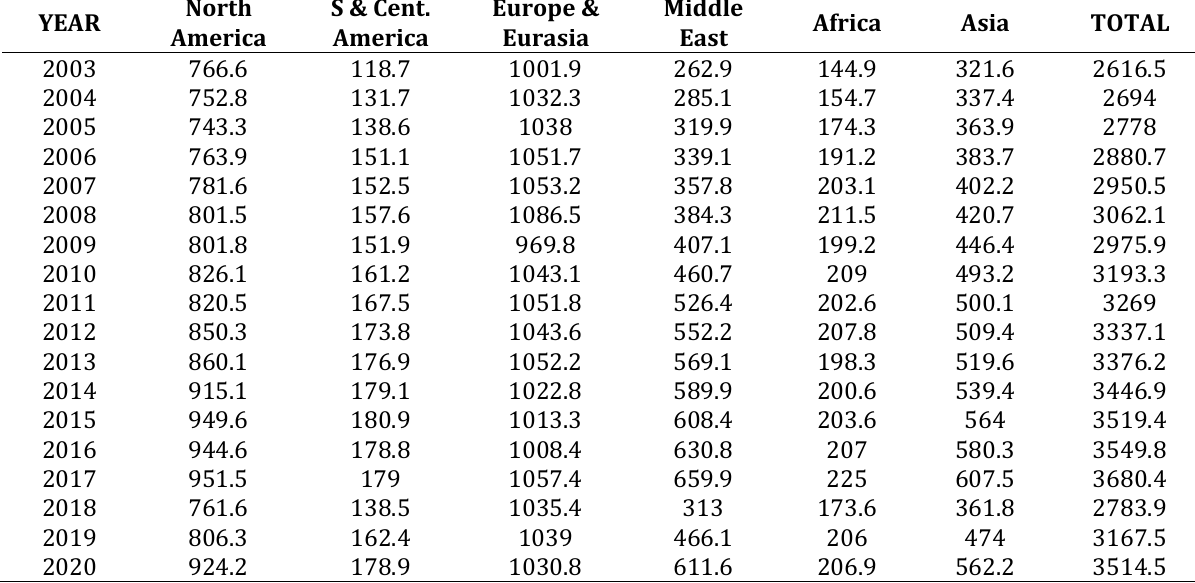
Table 1: Natural gas production in billion cubic meters